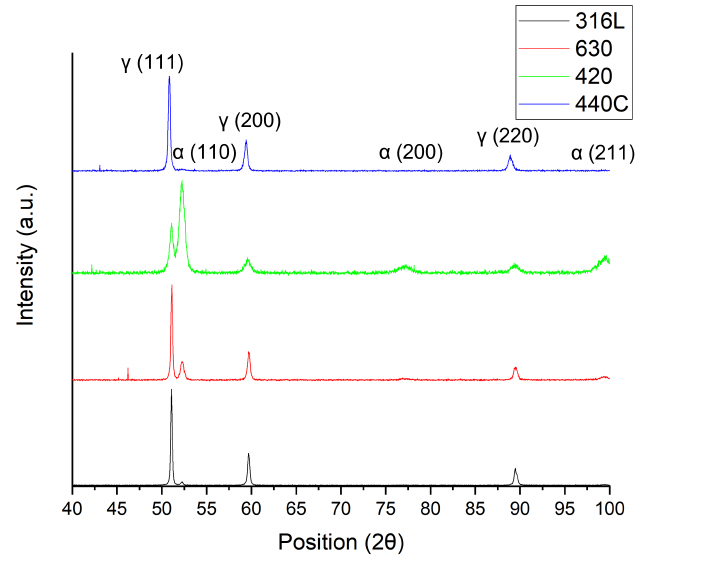
Figure 4. X-ray diffractograms of the 316L, 630, 420 and 440C powders (from bottom to top, respectively).